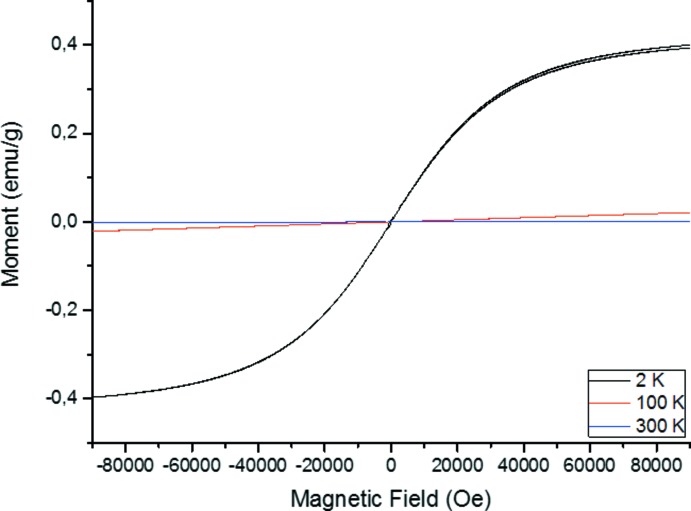
Dependence of magnetization on the magnetic field at 2, 100 and 300 K.